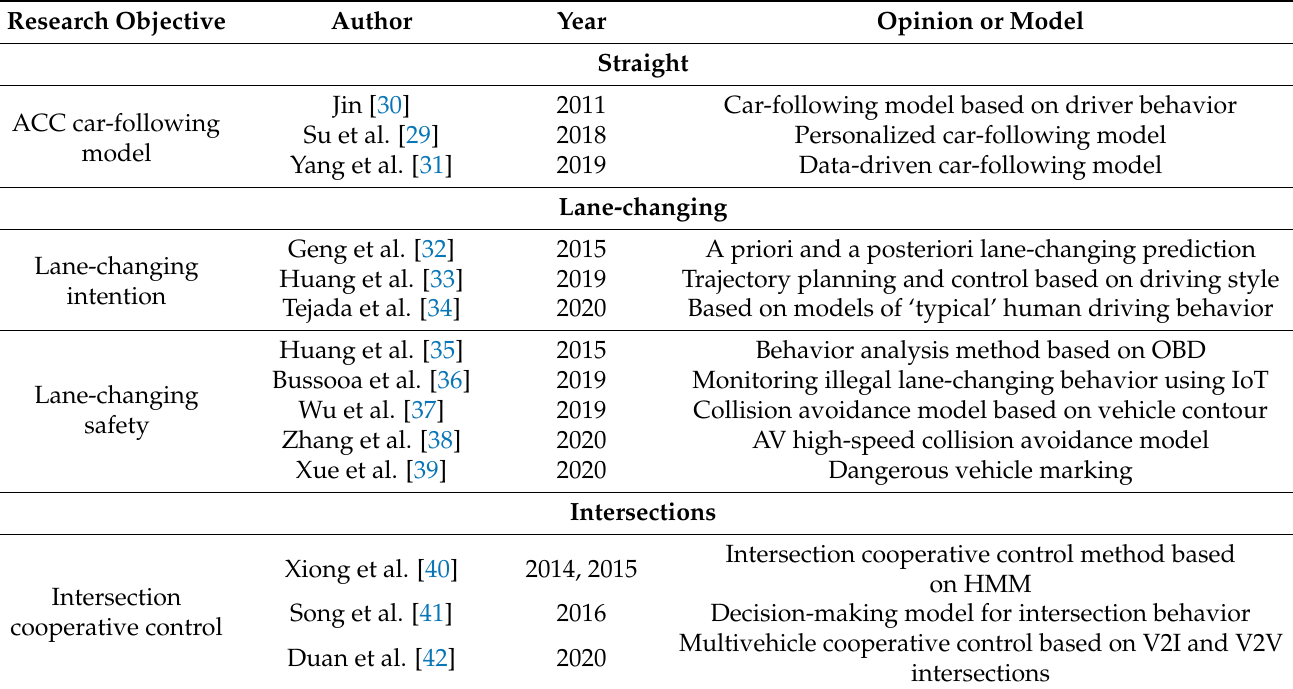
Table 4. Research summary of IoV driving behavior